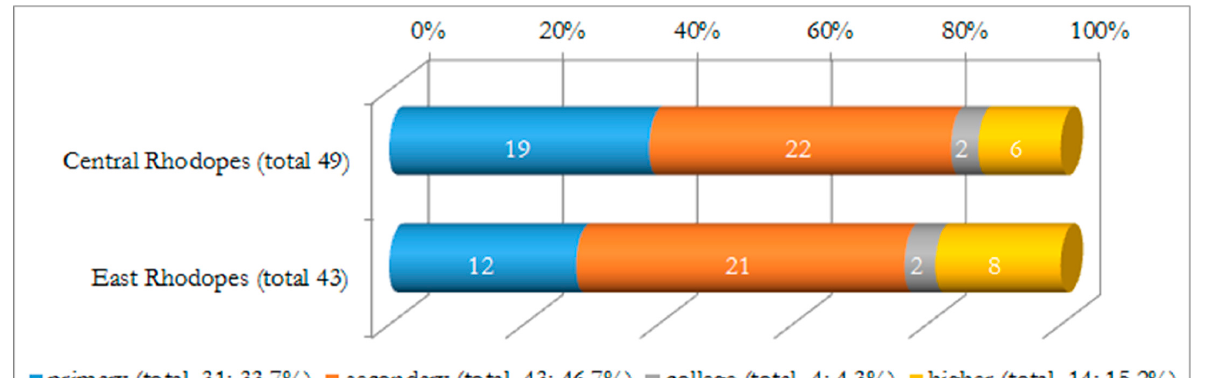
Figure 2. Demographic characteristics of informants by region and age.